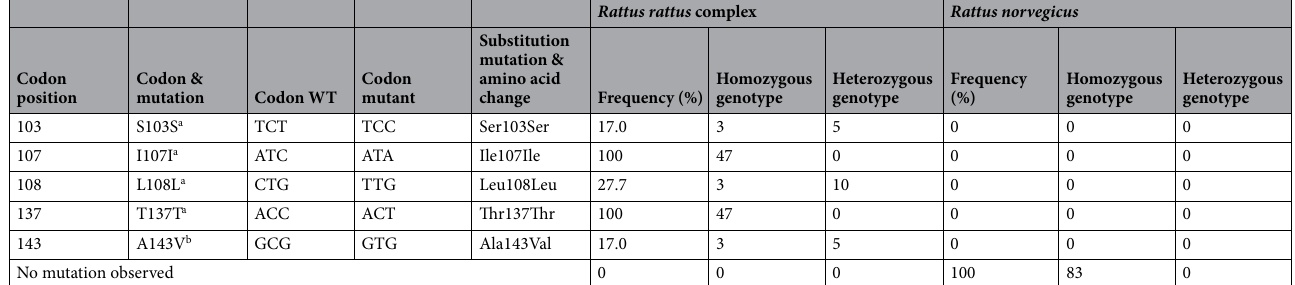
Table 1. Summary of SNPs found in exon 3 of Vkorc1 with the respective substitution of amino acids of R. rattus complex ( n = 47) and R. norvegicus ( n = 83) when compared to the GenBank AY423047 wild type sequence. a SNP mutation that is silent. b SNP mutation that brings about a substitution in amino acid. WT wild-type sequence/amino